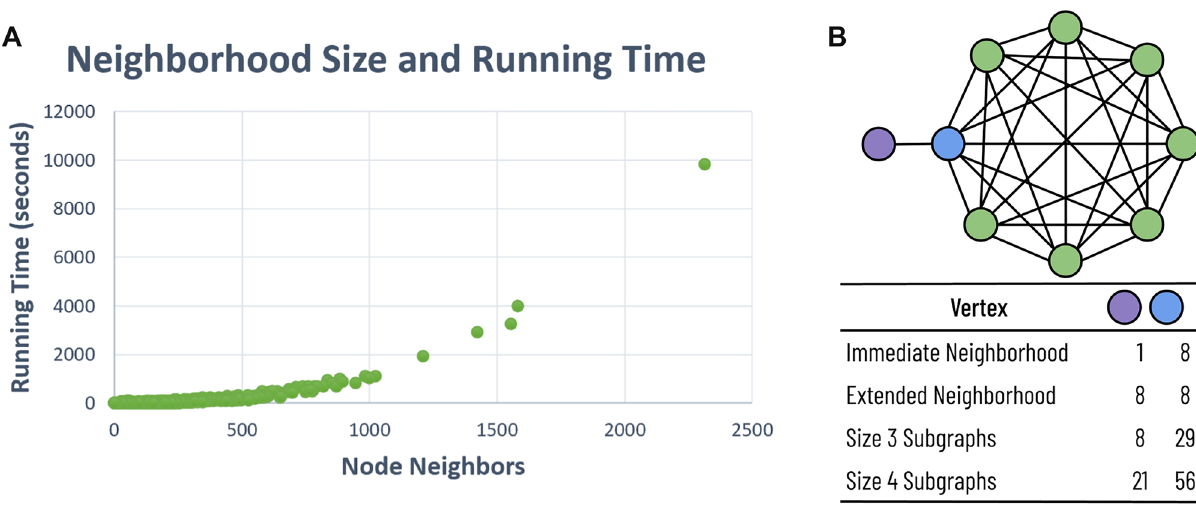
Figure 5. Enumeration times and neighborhood sizes. ( A ) There is a non-linear relationship between the number of neighbors and the running time required. We can reduce running time variance by reducing neighborhood size variance. ( B ) Although immediate neighborhood size is a good indicator of the number of enumerated subgraphs, there is little correlation between the extended neighborhood size and the number of